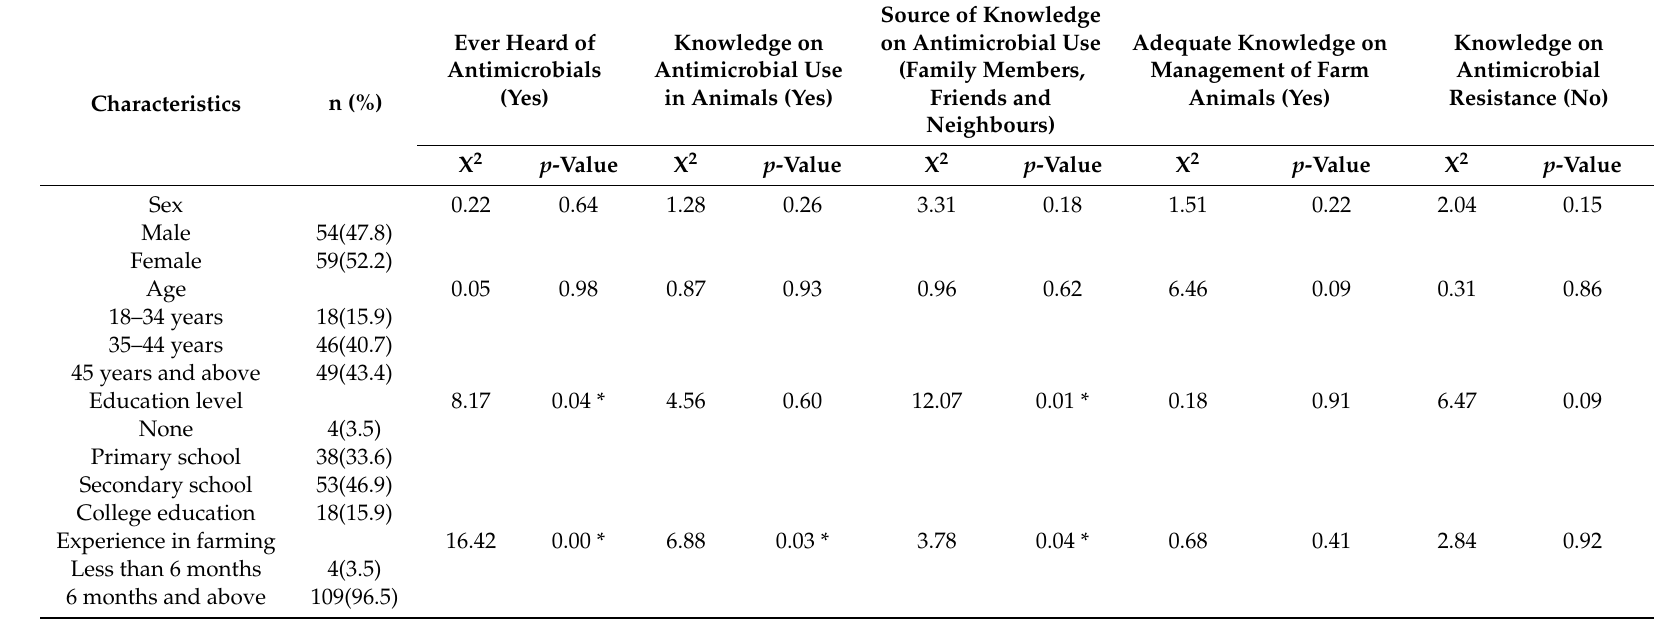
Table 2. Number and percentage of respondents on the knowledge of antimicrobial use ( n =